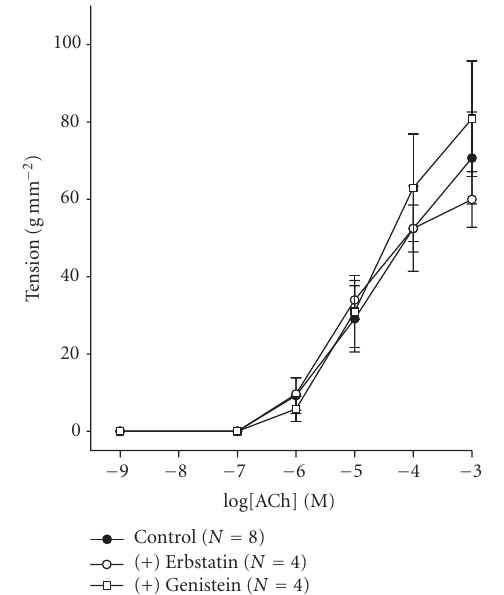
Figure 5: Concentration-e ff ect curves for acetylcholine at an RT of 2.5 g in the presence of tyrosine phosphorylation inhibitors. Data are means and vertical lines show SE. N refers to the number of animals